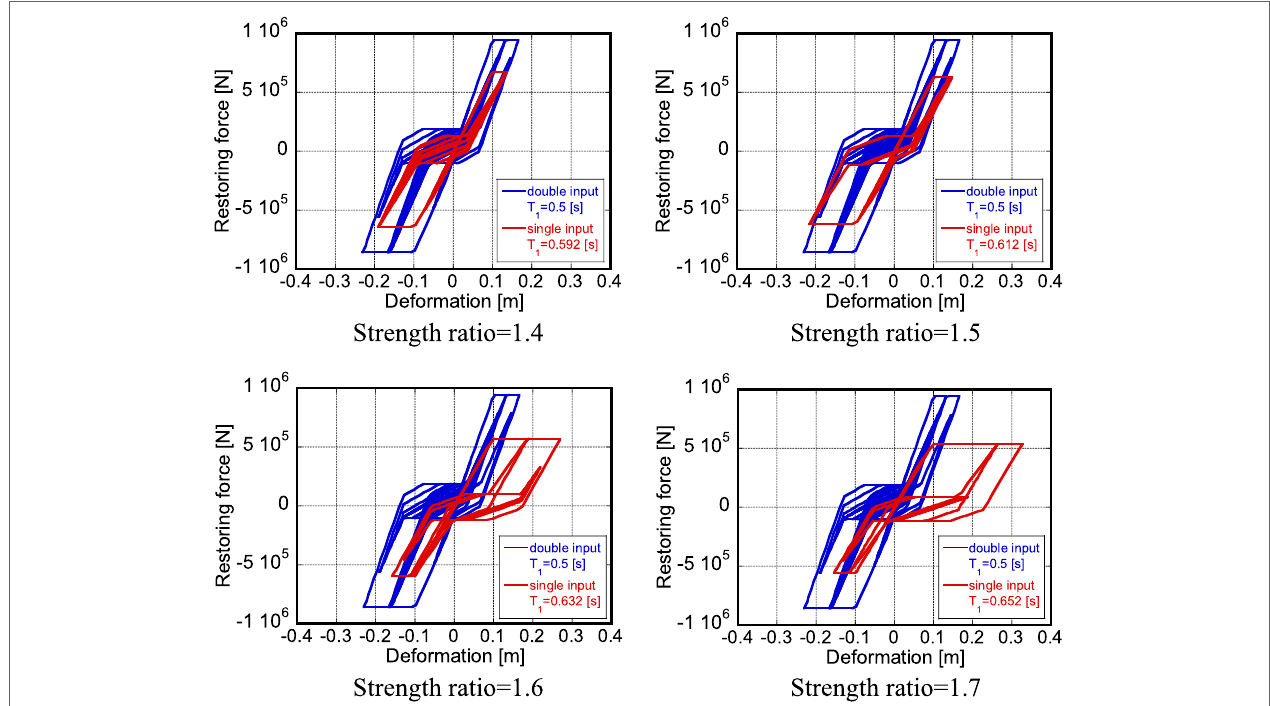
FIGURE 15 | Restoring-force characteristics of models with different strength ratios under repeated 2016 Kumamoto earthquake ground motion (April 16) designed so that they just collapse after one impulse or two impulses [reference model: collapse just after two impulses/slip and bilinear model (wooden structures)] .